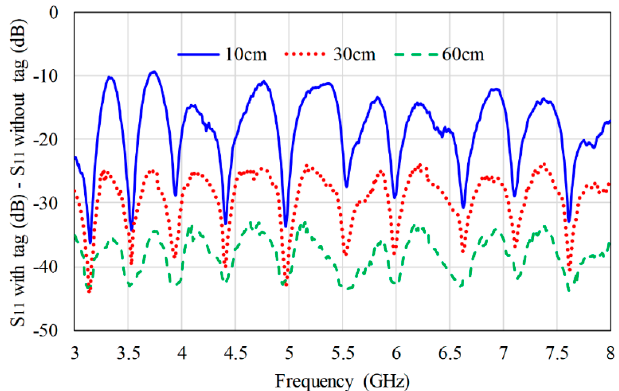
Figure 17. Measured responses of the nine unit cells at di ff erent